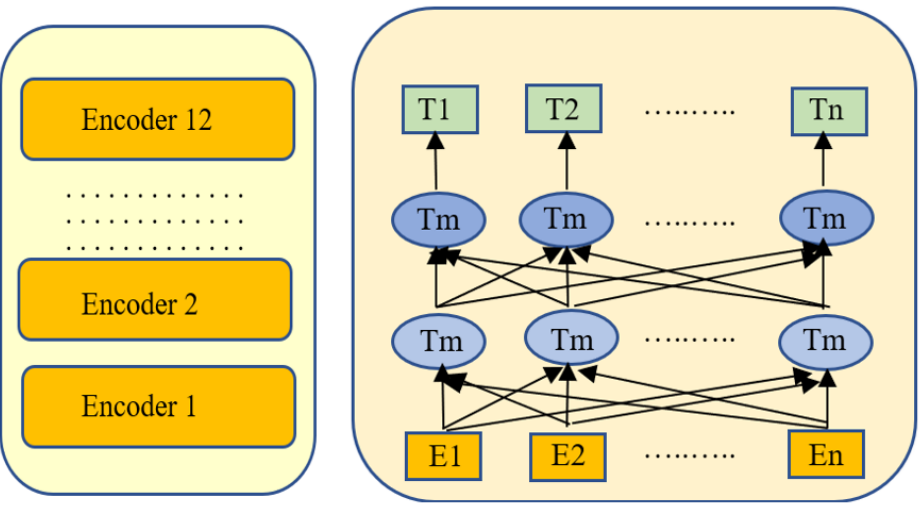
Figure 8. The architecture of BERT-base. 12 stacked encoders. [51].